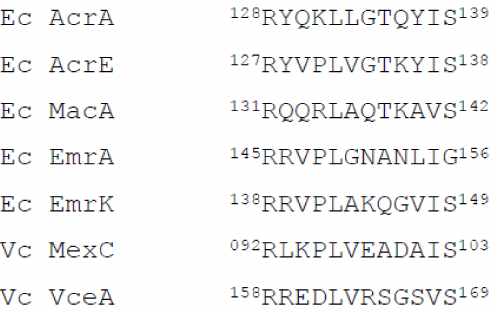
Figure 8. Sequence alignment of the PAPs in E. coli and V. cholerae . Ec AcrA (Genbank NP_414996); Ec AcrE (Genbank NP_417731); Ec MacA (Genbank NP_415399); Ec EmrA (Genbank NP_417170);